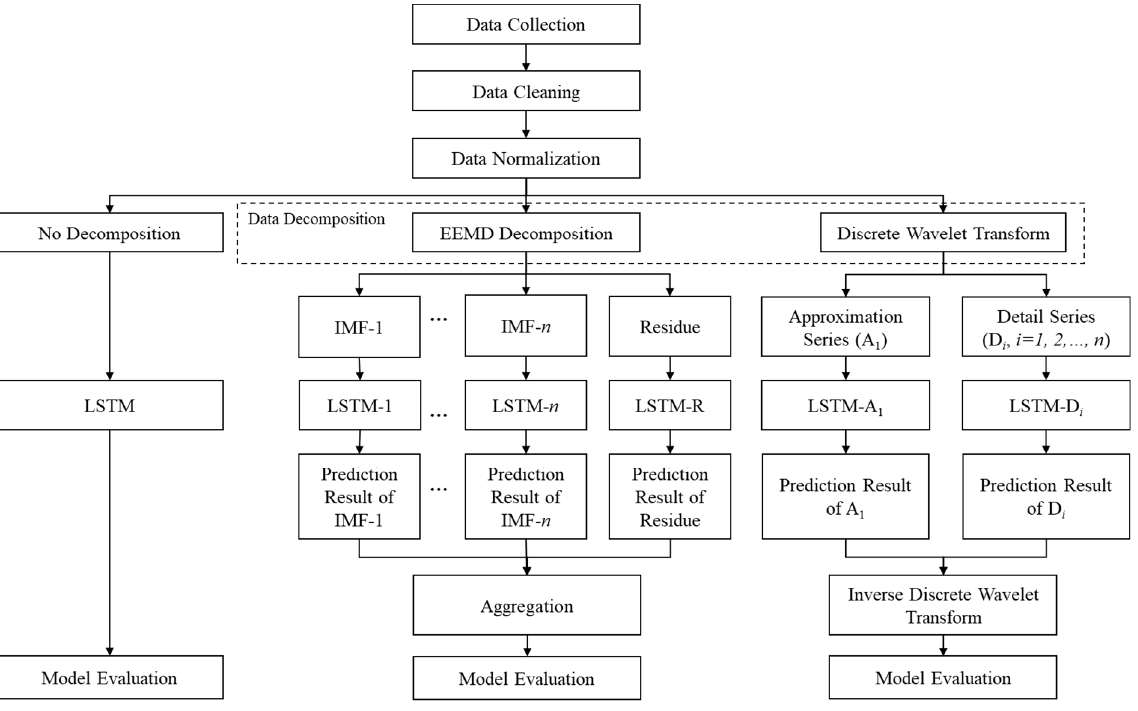
Figure 4. The proposed forecasting